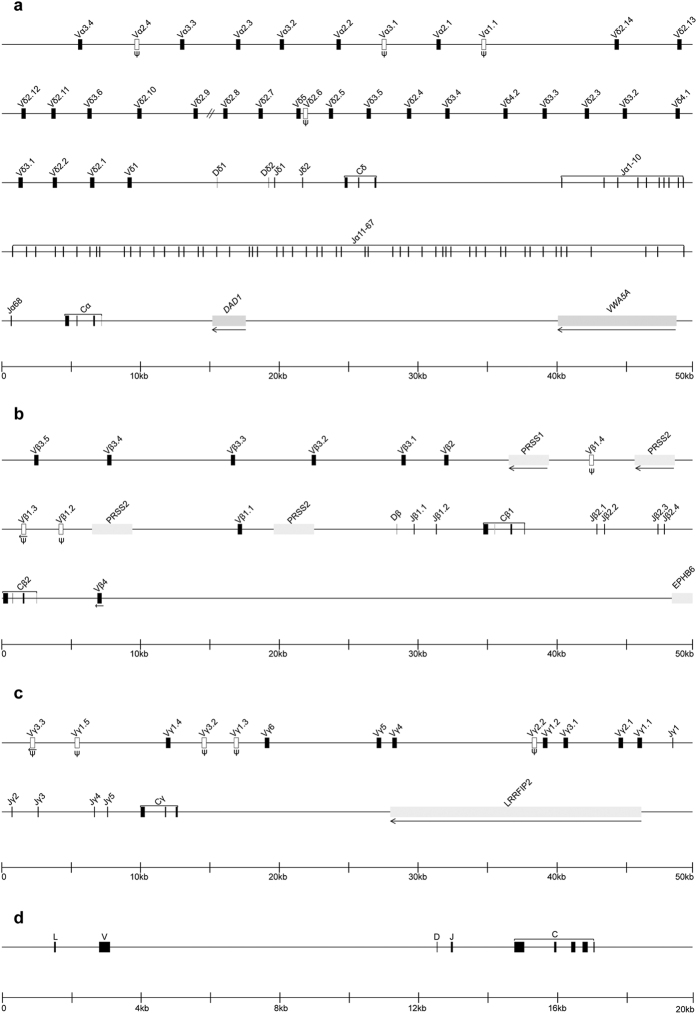
The genomic organization of duck TCR gene loci, TCRα/δ (a), TCRβ (b), TCRγ (c) and TCRδ2 (d). V, variable gene segment; D, diversity gene segment; J, joining gene segment; C, constant gene segment. V segments are named 3′ to 5′ with the subgroup number followed by the gene segment number if there were more than one member in the subgroup. Functional V segments are shaded, and pseudogenes are shown in hollow boxes and marked with a ψ. Non-TCR genes located in or flanking each TCR locus are shown in light grey. V segments and non-TCR genes with an opposite transcriptional orientation to the relevant C region are indicated by an arrow, and the sequence gap in (a) and (c) is marked as //.